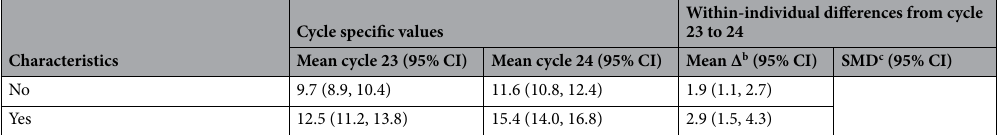
Table 1. Weighted a cycle-specific means, mean of within-individual differences (Δ) and standardized mean changes (SMD) for MDI scores from cycle 23 to 24, Nicotine Dependence in Teens study, Québec, Canada 2017–2021, n = 673. a Weighted for non-response. b Represents individual differences between MDI or GAD-7 scores in cycle 24 and 23. c Represents differences in mean change between groups, divided by the within-group standard deviation averaged across cycle 23 and 24. 95% CIs were calculated using bootstrap resampling. SMD with 95% CI that excluded the null are in bold